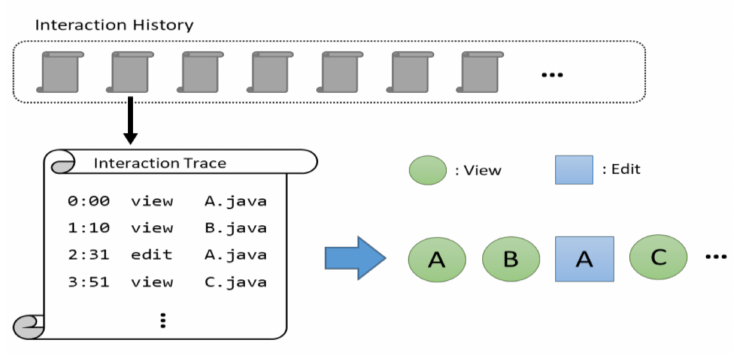
Figure 3. The process of generating an interaction history.